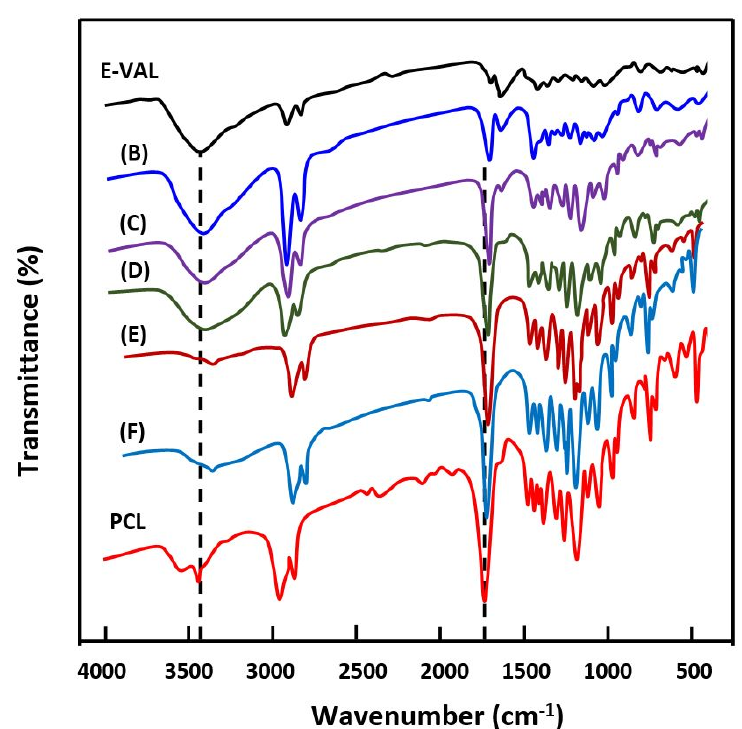
Figure 1. FTIR spectra of poly(ethylene- co -vinyl alcohol) (E-VAL), poly( ε -caprolactone) (PCL) and their blends containing (B) 90, (C) 75, (D) 50, (E) 25 and (F) 10 wt% E-VAL.